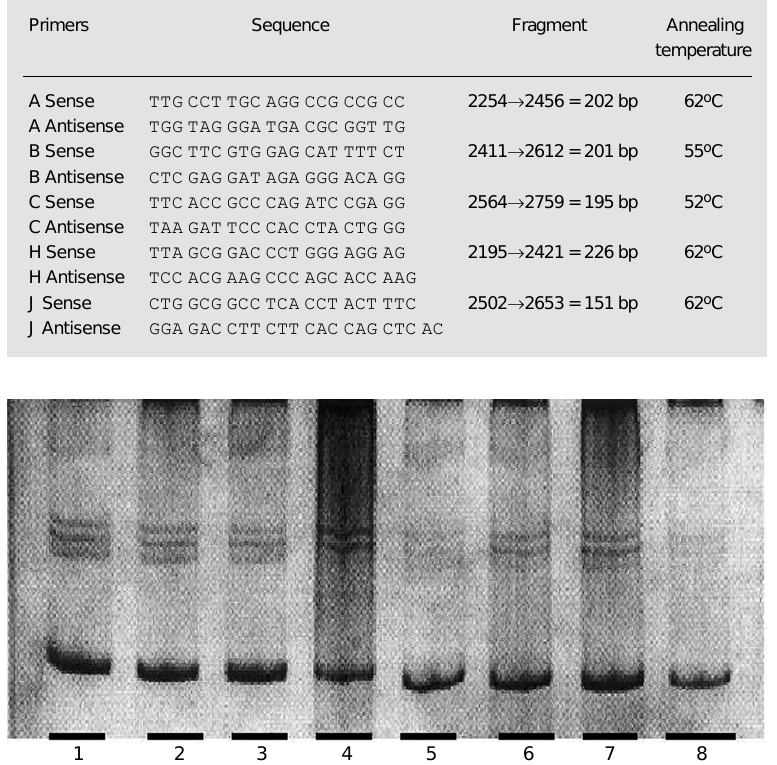
Figure 1. Gel of single-stranded conformation polymorphism (SSCP) analysis representative of our results for exon 2 in the multiple endocrine neoplasia type 1 ( MEN1 ) gene screening for mutations. PCR products were loaded from normal tissue from the contralateral lobe of a thyroid follicular carcinoma (lane 1), from the thyroid follicular carcinoma of the same patient loaded on lane 1 (lane 2), from a thyroid papillary carcinoma (lane 3), adrenocortical carcinoma (lane 4), adrenocortical carcinoma (lane 5), adrenal adenoma (lane 6), breast infiltrating ductal cancer (lane 7), and thyroid papillary carcinoma